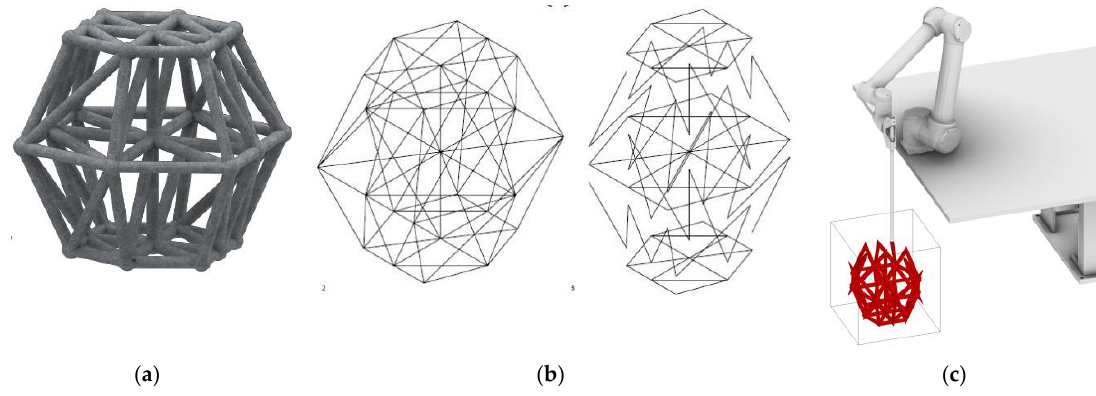
8 of 17 Figure 6. Results of the calibration process: ( a ) a spiraling geometry printed in gel; ( b ) a more complex geometry printed in a 1:1 gel-sand suspension. In order to prevent the decomposition of the gel, as well as the formation of the white skin, and to counteract progressive sinking of the printed structure, two alternative support mediums were developed and tested. Firstly, in an effort to achieve greater overall stability (in terms of the material decomposition as well as printing support), the same bulk volume of quartz sand was added to the pure gel. Additionally, a less sensitive and more cost-effective limestone-sand suspension was developed, which did not require the use of expensive gel at all. Both mediums were tested and compared in printing experiments (Figure 7). ( a ) ( b ) Figure 7. Objects printed in two different support mediums: ( a ) printed in a gel-sand suspension; ( b ) printed in a limestone powder quartz sand suspension. For the gel-sand suspension no formation of a white skin was observed, and only a very small amount of water accumulated on the surface of the printing container. When extruding within the limestone-sand suspension, it was observed that furrows were created behind the printing nozzle, when moving through the gel. Those furrows saturated with concrete, leading to the creation of ridges above the print trajectory (Figure 7b). In further experiments this was corrected by increasing the water content by 3%. In contrast to the gel-based suspensions, no problems with water going through the limestone-sand suspension on the suspension’s surface were observed at all. 5.1.2. CiS Demonstrator